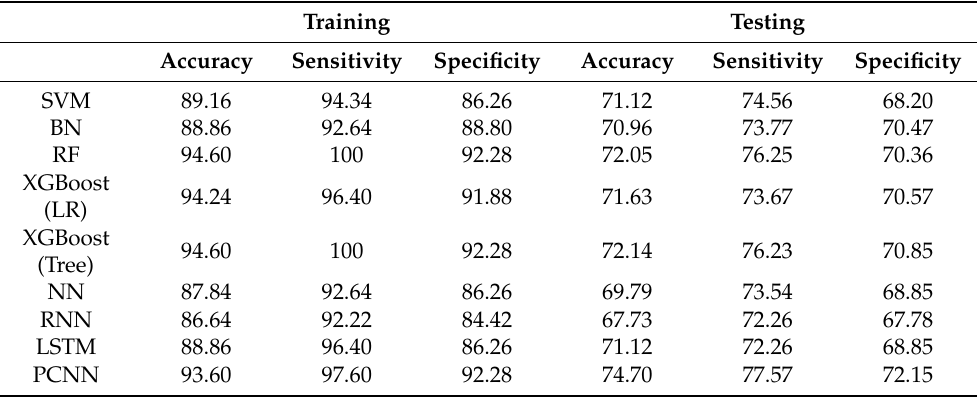
Table 4. Performance measures (training, testing = 66:33). SVM, support vector machine; BN, Bayesian network; RF, random forest; NN, neural network; RNN, recurrent neural network; LSTM, long short-term memory; PCNN, partial correlation neural network.